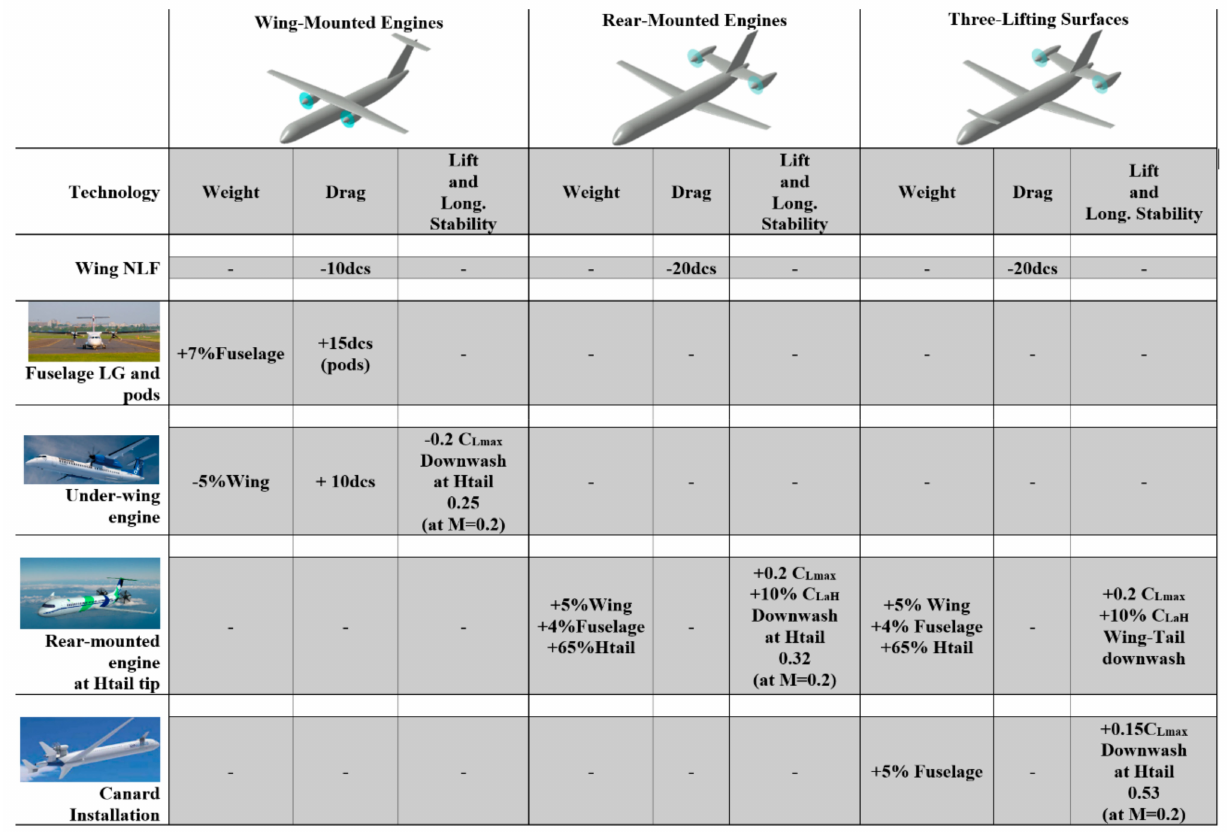
Figure 8. Technological assumptions for each considered aircraft